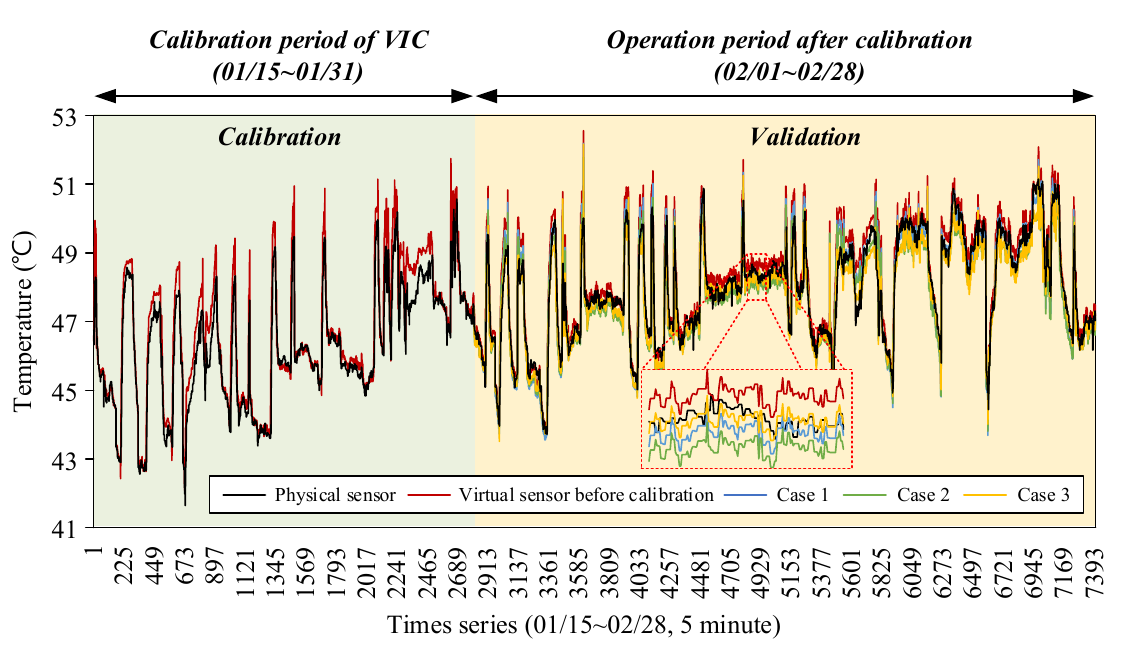
Figure 6. Virtual sensor measurements before and after all calibration cases throughout the entire operation.